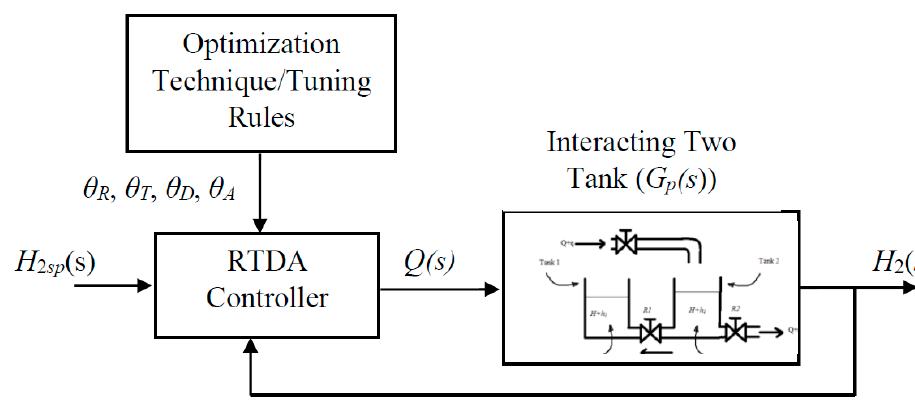
Figure 9. Level control system with the RTD-A controller.